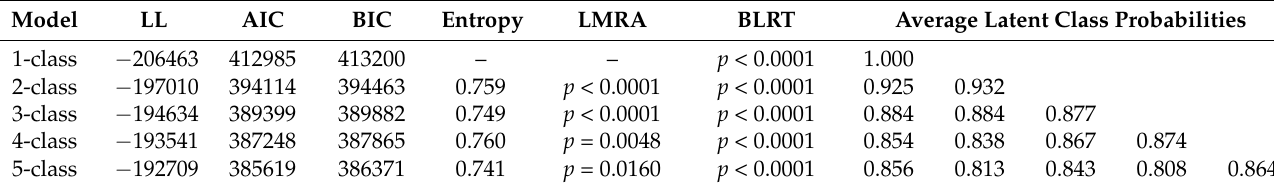
Table 3. Latent class model